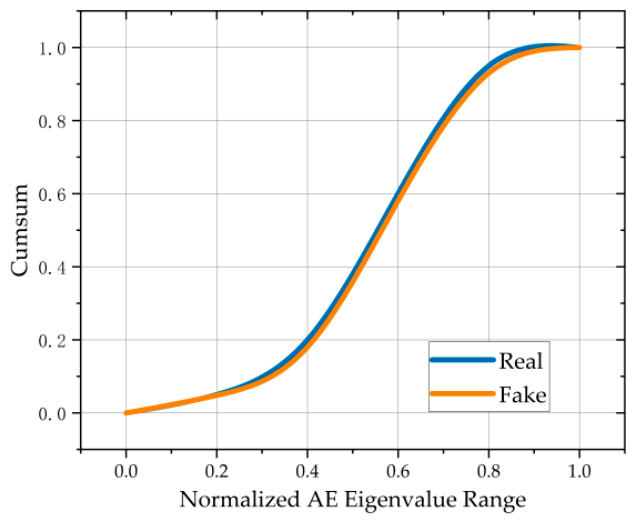
synthetic data are marked in orange, and the displayed results are shown in Figure 11.